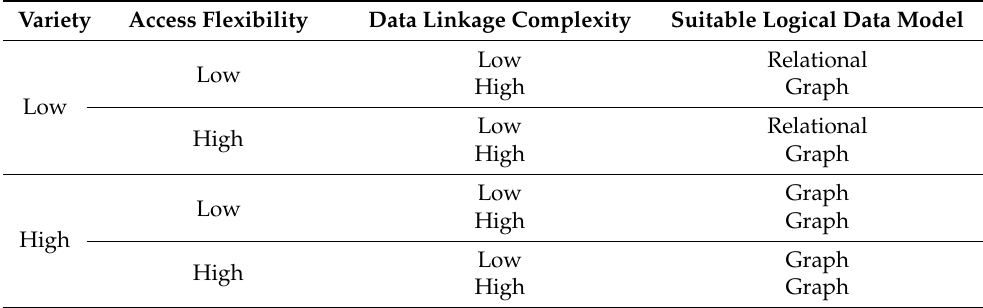
Table 3. Most suitable data model with ACID properties according to veracity, access flexibility, and data linkage complexity.